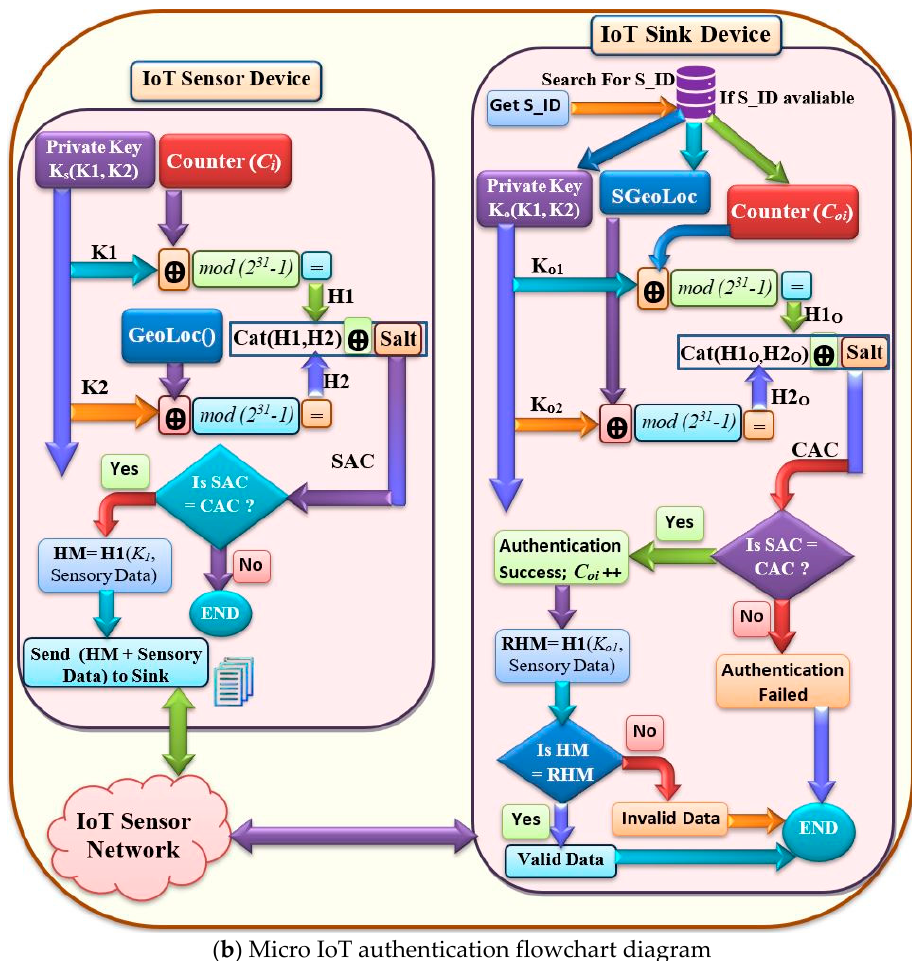
Figure 2. System design of Micro IoT authentication.